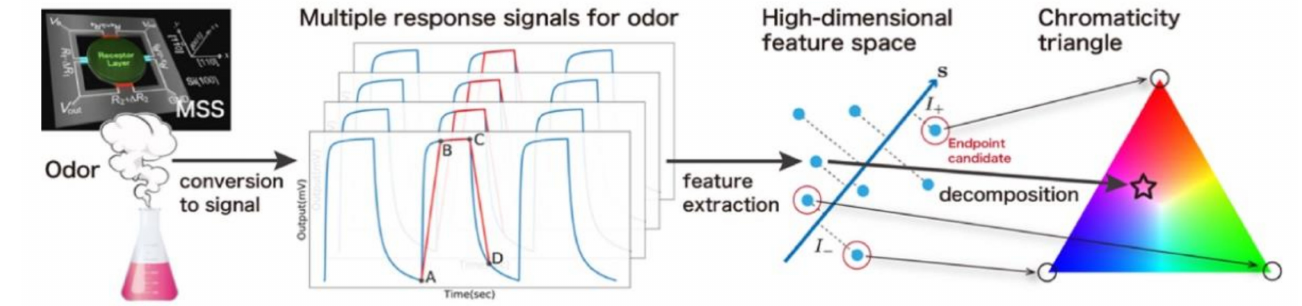
Figure 14. Overview of the determination of quasi-primary odor by combining machine learning and nanomechanical sensing. In the first step, the odor samples are converted to response signals with the MSS. From MSS signal responses, characteristic features are extracted. By performing machine learning-based endpoint detection, selected numbers of quasi-primary odors are determined (in this case, three). They are placed at the vertices on a chromaticity triangle and the other odors are expressed as a mixture ratio of the three quasi-primary odors, resulting in the color representation of each sample. Reprinted from Ref. [10], the authors licensed under CC-BY